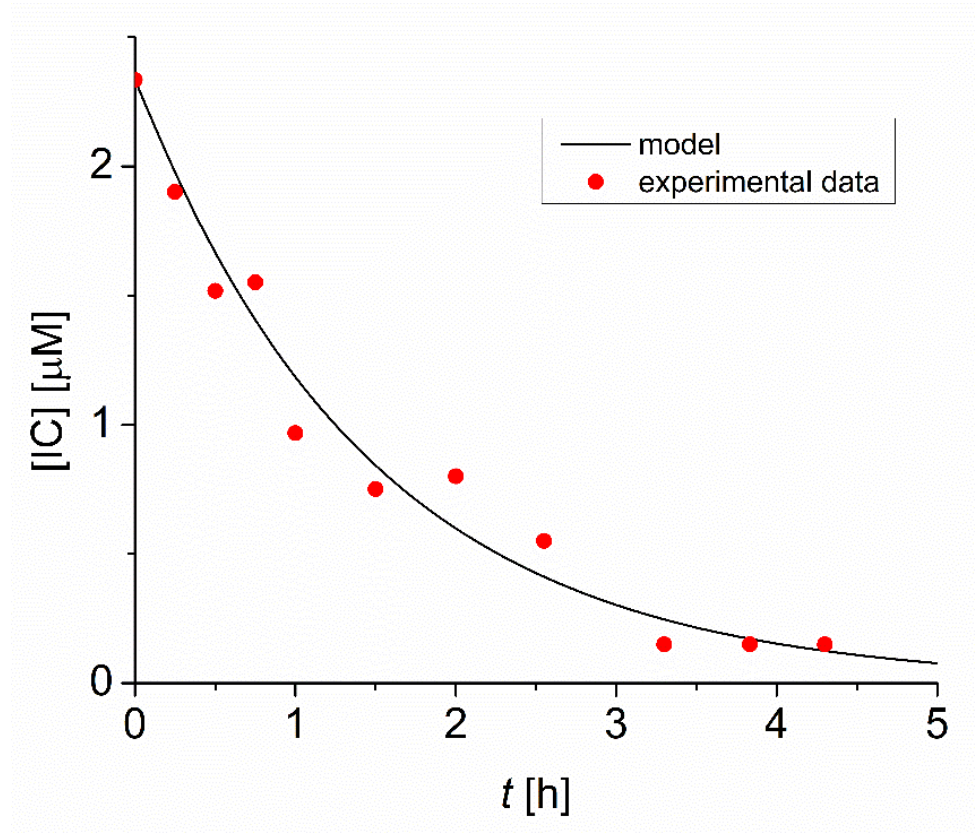
Figure 8. Degradation of the IC chromogenic bond, experimental versus predicted by the model. The good agreement between the experimental degradation data for the IC chro- mogenic bond and those obtained through the model (Figure 8) support the hypothesis that during the postdischarge phase, the most important mechanism of IC discoloration is by interaction with the OH˙ radical formed in the liquid bulk through the decomposition of O=NOOH [13].